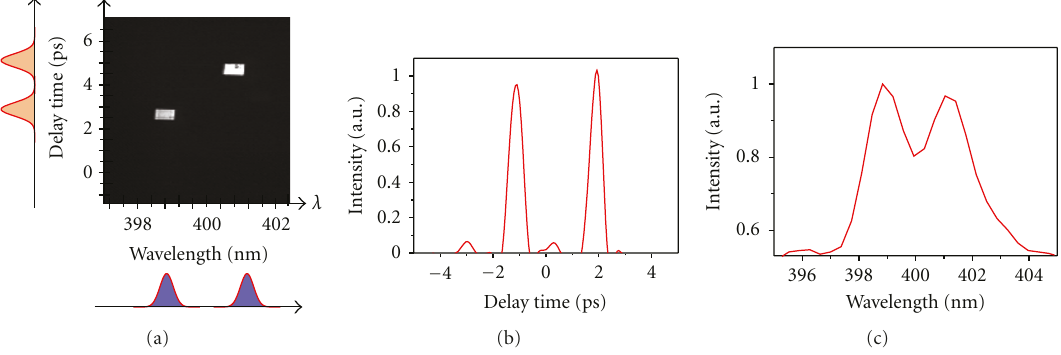
Figure 5: Experimental results for dropped signal ( λ 1 , t 1 ) and (b) ( λ 5 , t 4 ) after reconfigure operation: (a) spatial distribution, (b) temporal waveform, and (c)